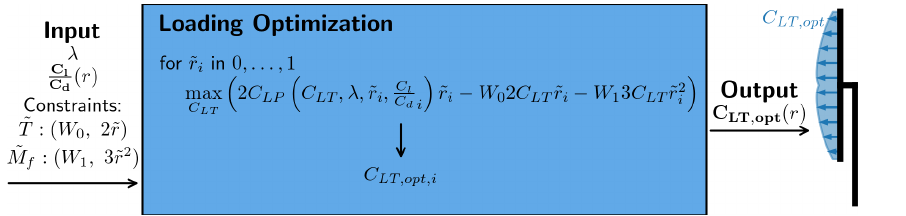
Figure 2. Flowchart for the loading optimization with a given set of inputs. Aerodynamic input: λ , C l /C d ; constraints input: ˜ T ≤ ˜ T 0 → W 0